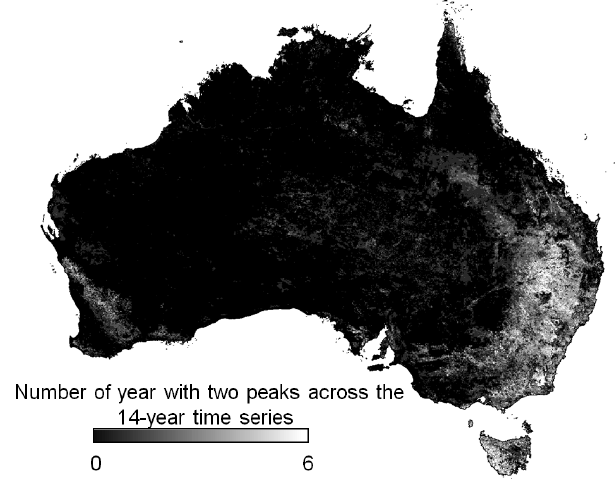
two peaks were detected, mostly associated with cropping or pas- ture land (Fig.